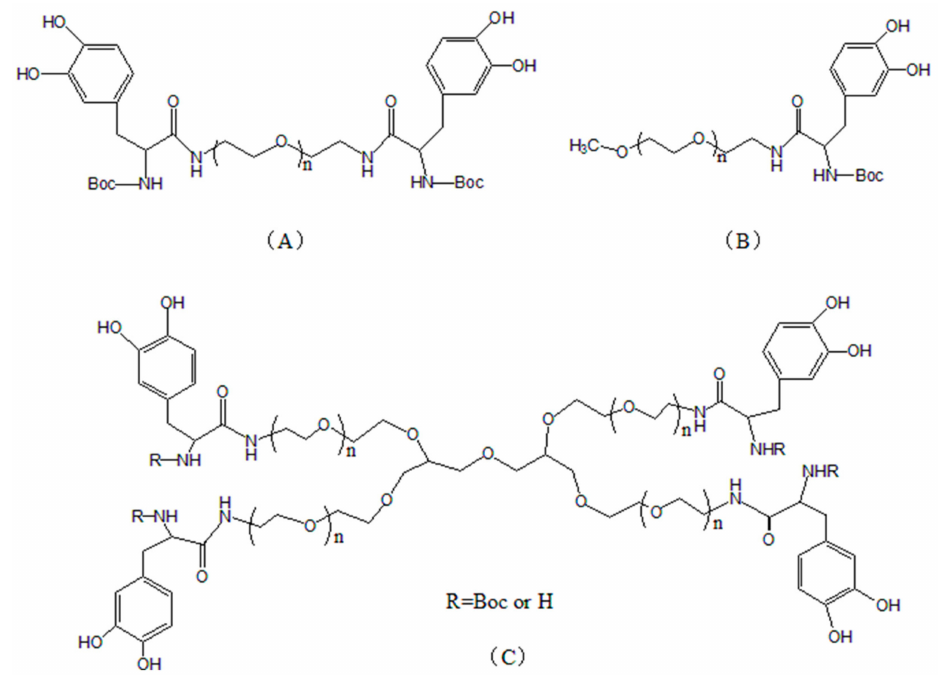
Figure 5. Chemical structures of DOPA-modified PEGs. ( A ) DOPA-modified PEGs containing two arms. ( B ) DOPA-modified PEGs containing one arm. ( C ) DOPA-modified PEGs four arms. Reproduced with permission from Ref. [59], Copyright 2002, American Chemical Society.